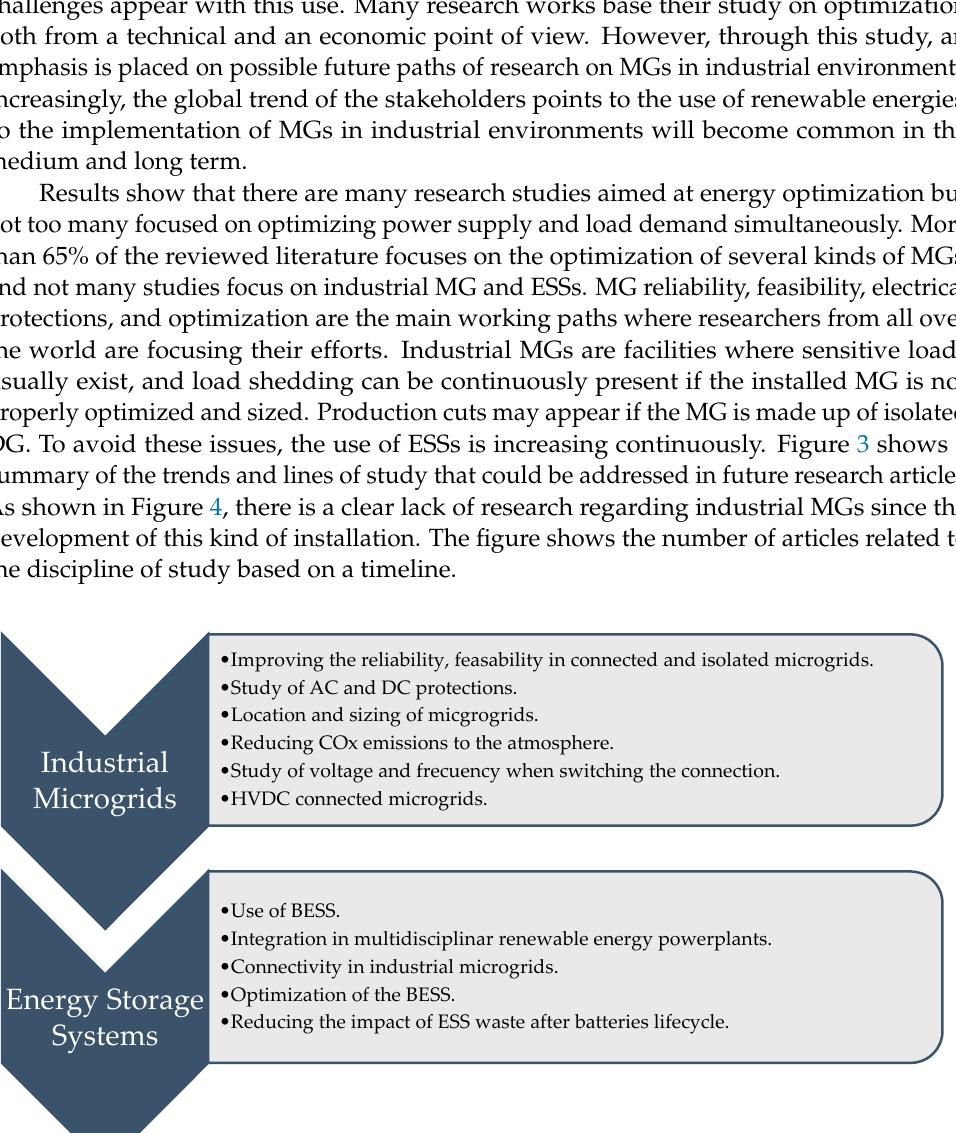
Figure 4. Articles reviewed and divided into MGs/MGs Optimization, ESS and Industrial MGs (source: own elaboration). PV facilities in Spain have increased considerably from the year 2019 to the present. This fact involves the expected change for the self-consumption scheme and a high impact on the PV development. There are not so many studies regarding the research of the MGs using ESSs in industries although some important electrical equipment manufacturing companies arise today. 5. Conclusions Renewable energies are increasing due to the drawbacks that fossil fuels present. Not so many studies address MG implementation in industrial environments. This paper pro- vides a timely and comprehensive review of the state-of-the-art of industrial MGs based on renewable energies. There are many definitions of the term “microgrid”. Today, this type of electrical installation is being implemented in the world since it presents numerous